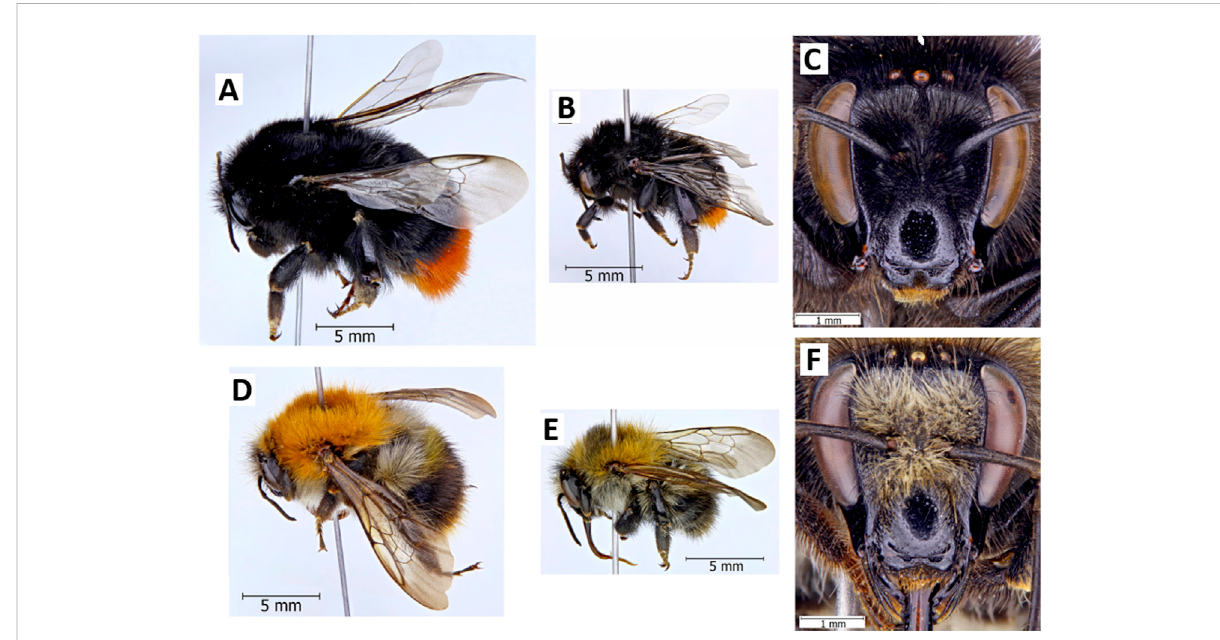
FIGURE 2 Mapofthe97sampling sitelocationsacrossEurope.Thepiecharts representsthenumberof B.pascuorum (inred)and B.lapidarius (in orange) specimenssequencedpersite.DatavisualisedwaswithRpackages ‘ rworldmap ’ (South2011)todrawthemapand ‘ ggplot2 ’ (Wickham2009)todraw the pie charts.